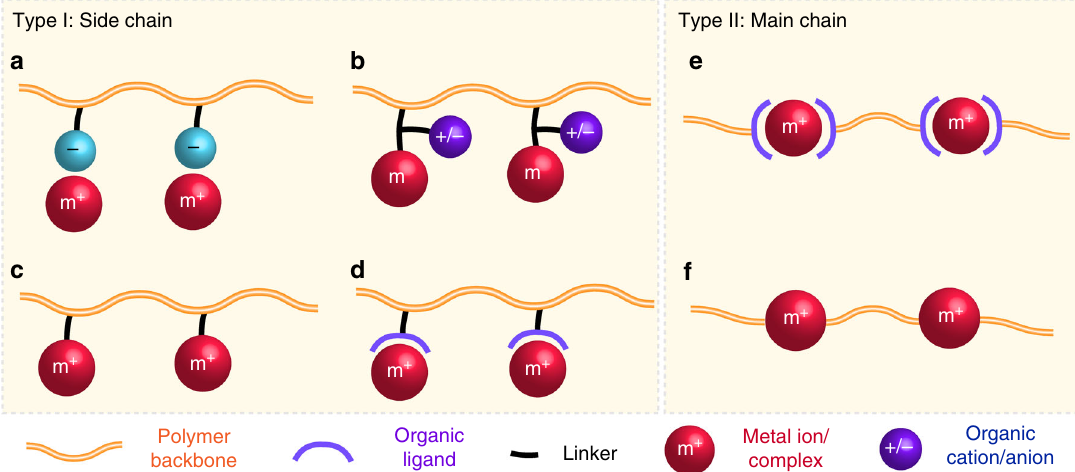
Fig. 1 Diverse topologies of metallo-polyelectrolytes. a metal ions attached to the side chain of organic polyelectrolytes through electrostatic interaction; b neutral metal complexes at the side chain of polyelectrolytes; c charged metal complexes at the side chain by covalent bonding; d charged metal complexes at the side chain through coordination; e main chain metallo-polyelectrolytes formed by coordination; f main chain metallo-polyelectrolytes formed by covalent